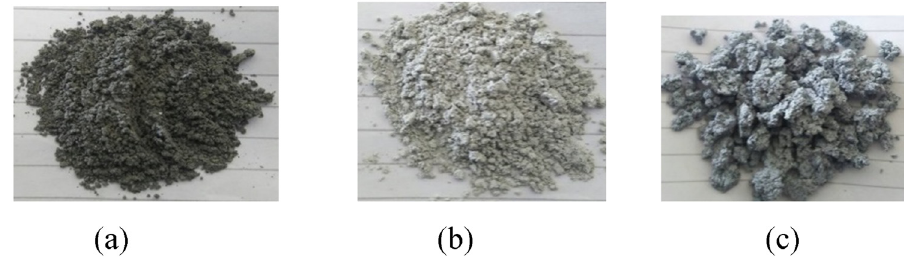
Figure 1: Bi/AC composites prepared with ( a ) 8 mmol, ( b ) 24 mmol, and ( c ) 32 mmol Bi ( NO 3 ) 3 · 5H 2